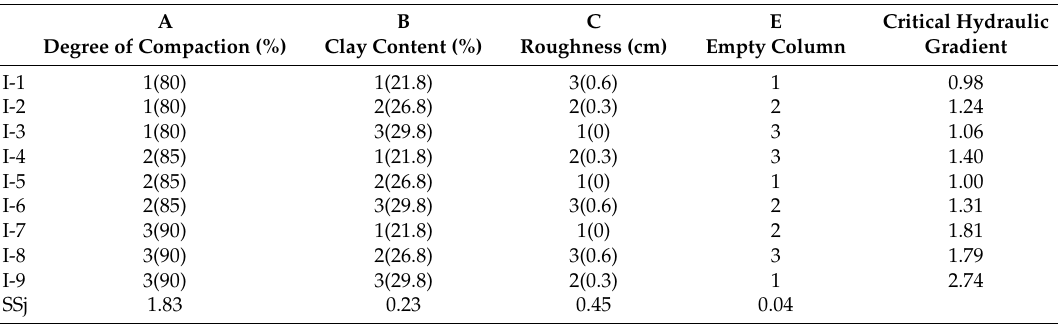
Table 5. Critical hydraulic gradient of orthogonal test results.